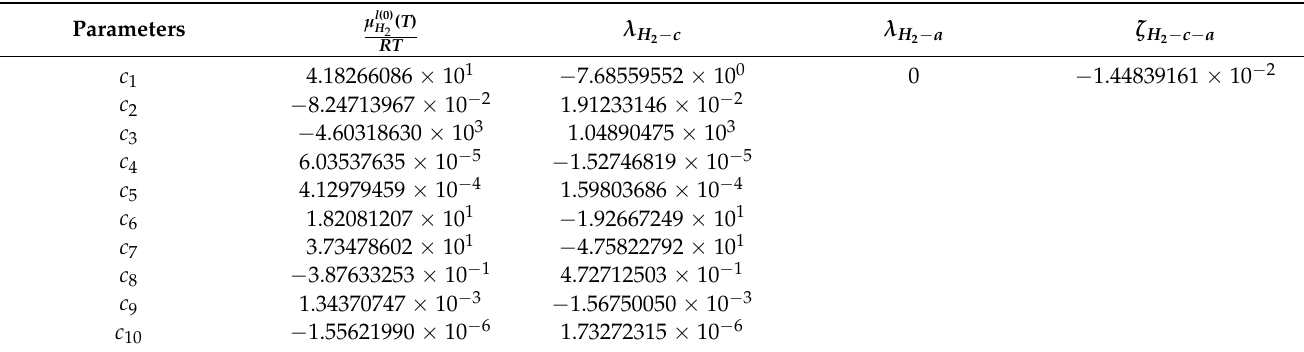
Table 3. Values of the interaction parameters in Equation (9).